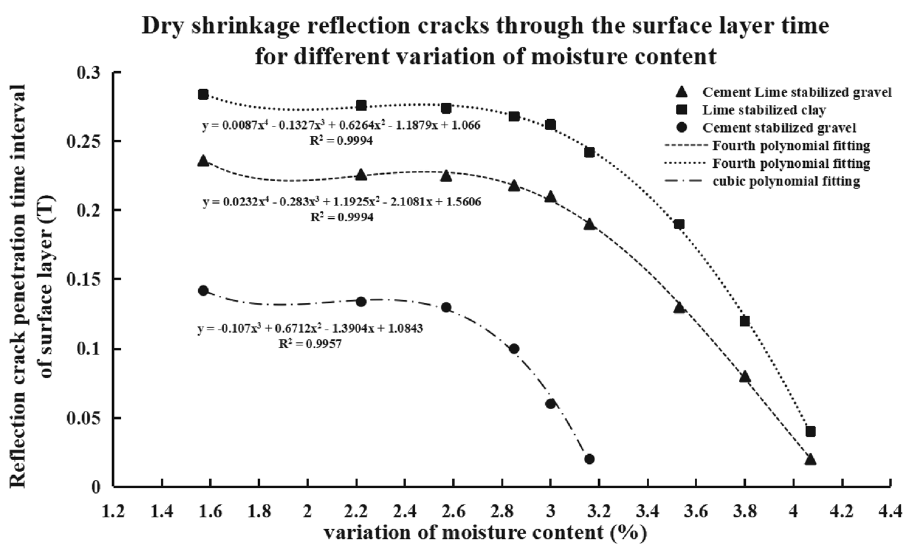
Fig. 12 The interval of cracks penetrating the surface layer with different variation of moisture